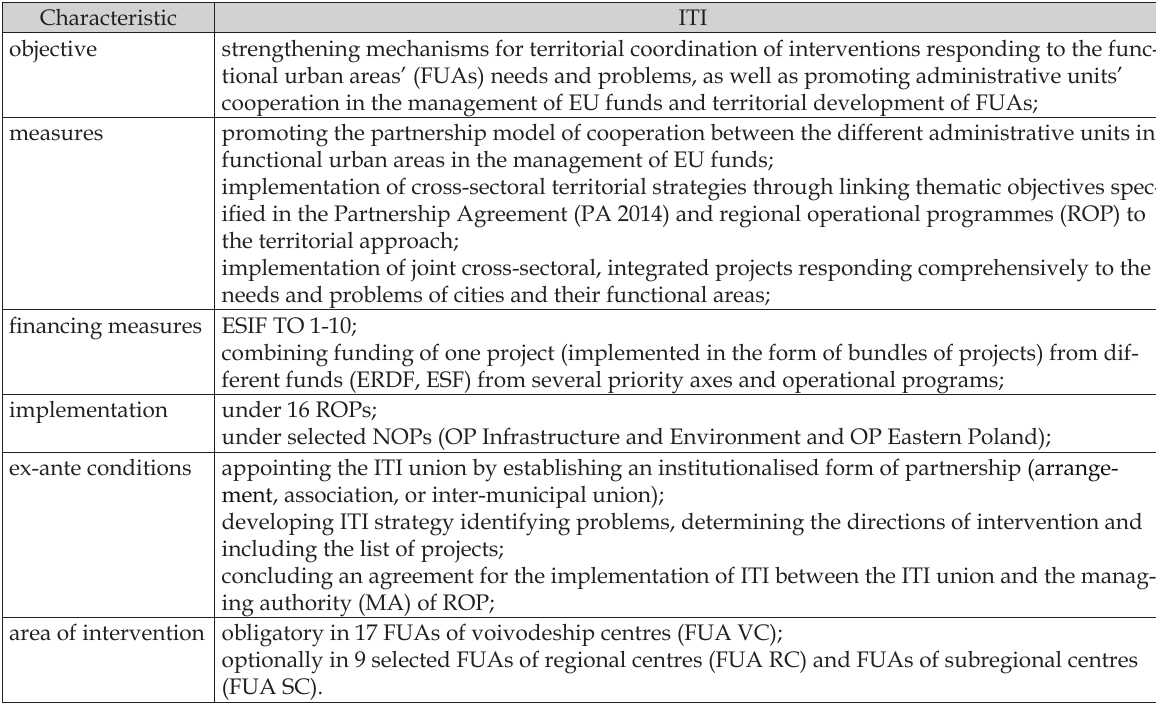
Table 1. Characteristics of the implementation of ITIs in Poland.